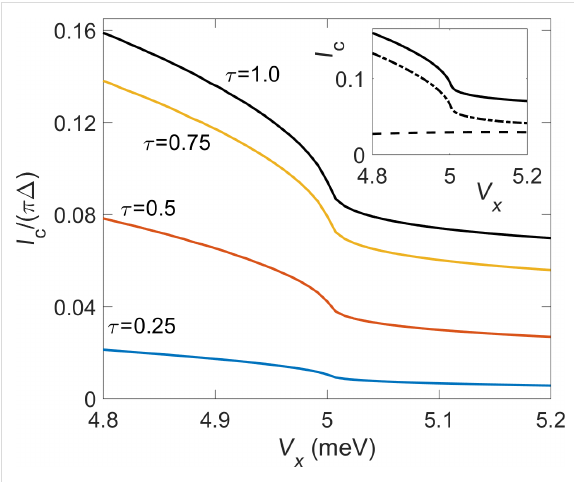
Figure 6: Main panel: Critical current I c vs Zeeman energy V x for an S–TS junction using the spinful TS nanowire model (Equation 34) for Δ p = Δ = 0.2 meV, μ = 5 meV, and different transparencies calcu- lated from Equation 36. All other parameters are specified in the main text. Inset: Decomposition of I c for = 1 into ABS (dotted-dashed) and continuum (dashed) contributions.